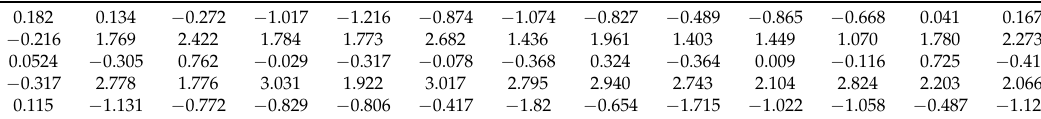
Table 9. The input weight values of the BPNN.